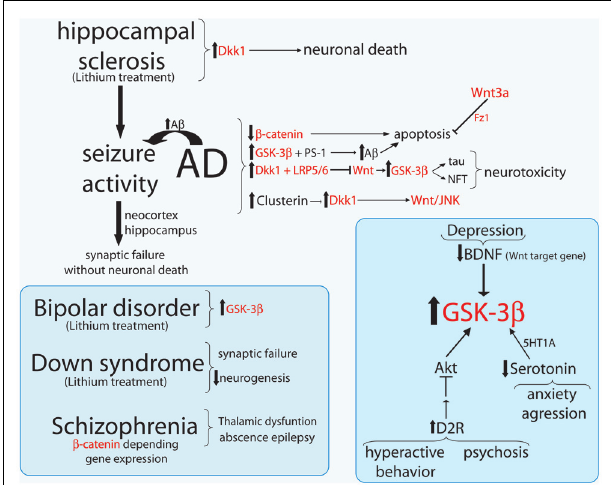
FIGURE 2 | Major neurological disorders and their relationship with Wnt signaling components. Summary scheme ofWnt signaling components (in red) involved in Alzheimer disease (AD), seizure activity (epilepsy), hippocampal sclerosis, bipolar disorder, down syndrome, and